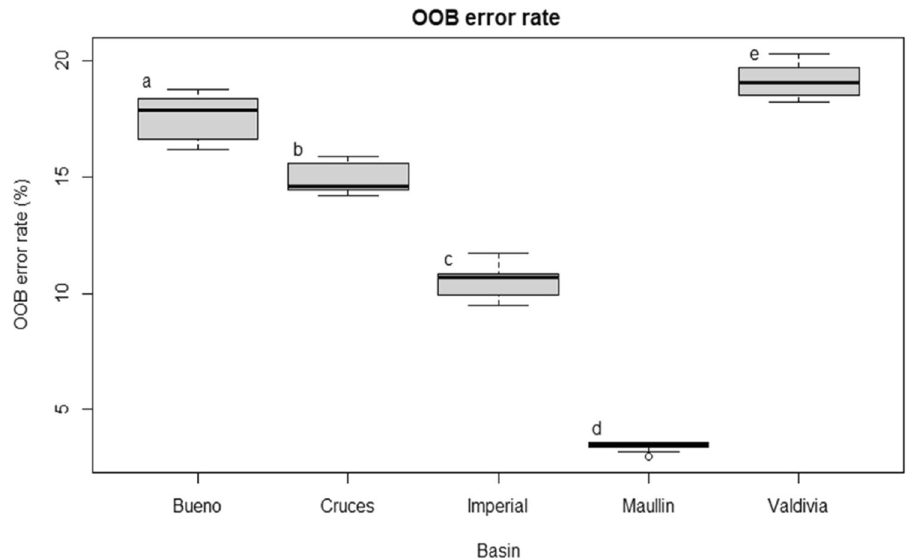
Figure 2. Out Of Bag (OOB) error rate (mean +/− s.d.) for the Random Forest models trained for each river system and each partition. Black lines indicate median values with surrounding upper and lower quartiles at the box edges. Mean and standard error were estimated from 100 simulations. Different letters indicate significant differences (ANOVA, F = 419.4, p <